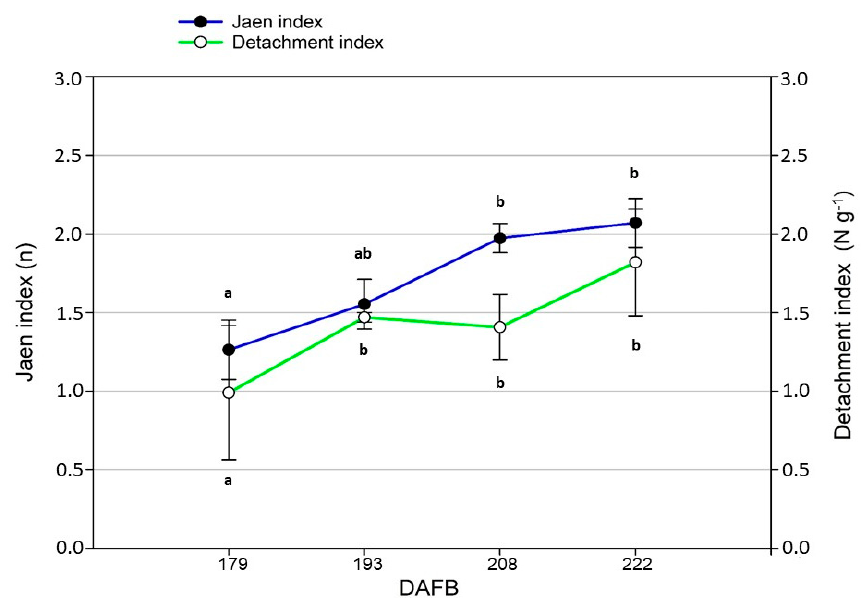
Figure 6. Jaen index ( n ) and detachment index (N g − 1 ) of olives of ‘Lecciana’ during ripening (DAFB = days after full bloom). Mean values of two subsequent seasons (± SE ). Lower case letters denote statistical differences at p = 0.05 (Siegel-Tukey test).